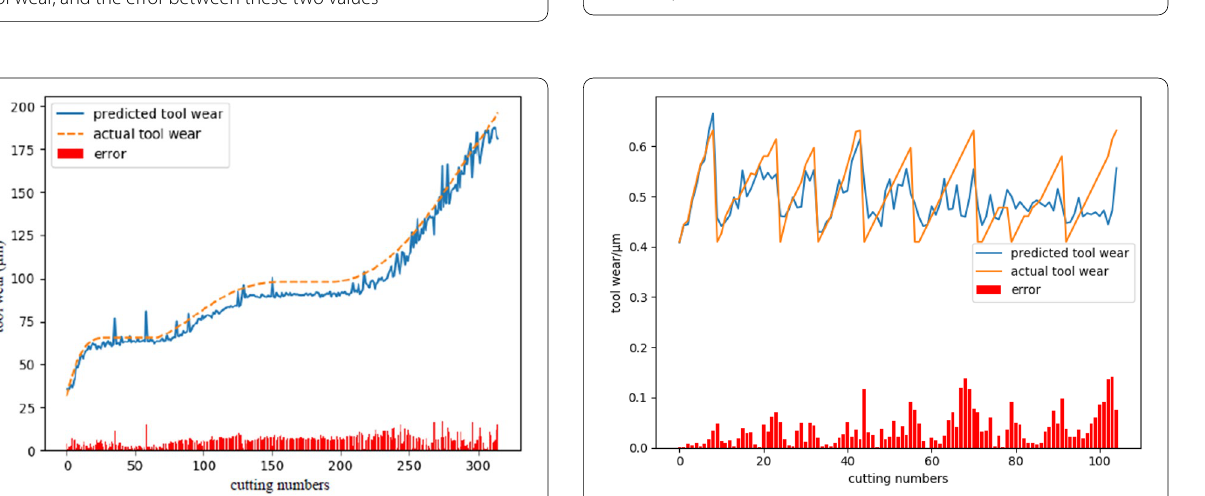
Figure 13 Results of the first experimental case, when c 6 is the testing set: the prediction of the tool wear, the corresponding actual tool wear, and the error between these two values